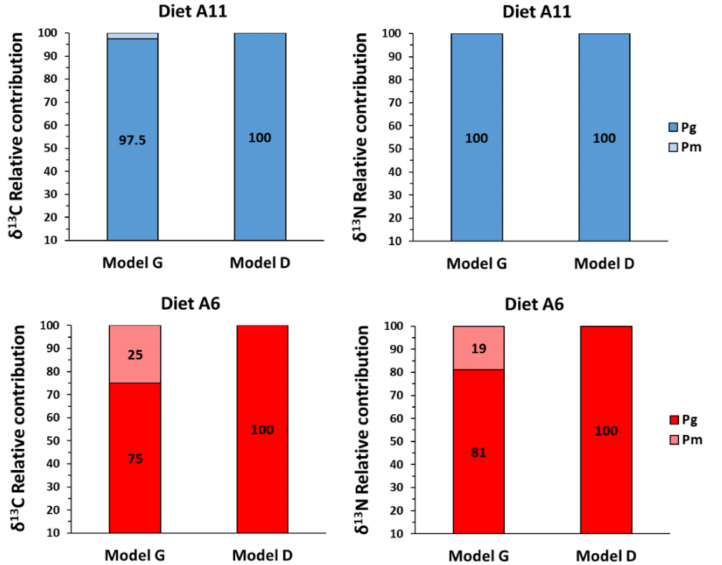
Figure 6. Relative contribution of growth (P g ) and metabolic (P m ) turnover to isotopic change ( δ 13 C and δ 15 N) estimated with a growth-based model (Model G) and a development-based model (Model D) in seahorse Hippocampus reidi juveniles fed on diets A6 and